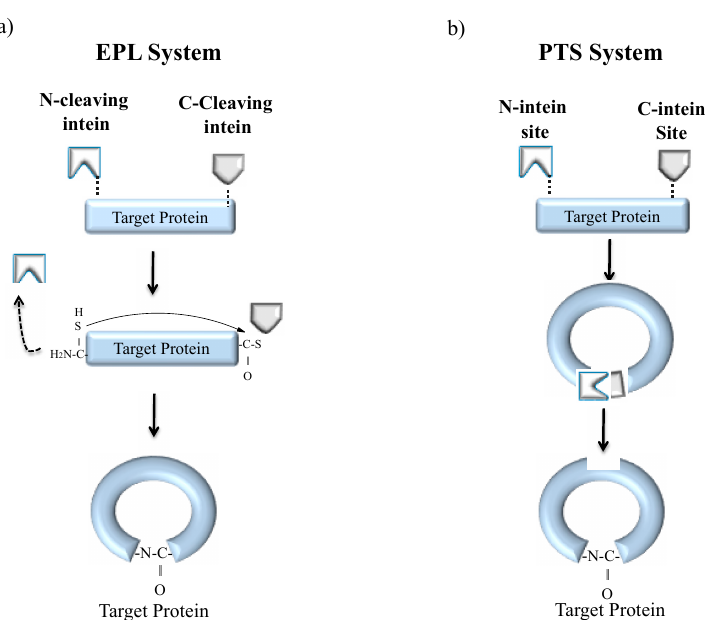
Figure 8. Schematic representation of intein-mediated post-translational modification of a target protein. ( a ) Expressed protein ligation (EPL) systems involve a nucleophilic attack by an N-terminal Cys residue on a thioester formed by a downstream intein. The N-terminal Cys can be generated by a second, upstream intein or by conventional proteolytic cleavage. ( b ) Protein trans -splicing (PTS) methods involves cyclization of a target protein tagged with N- and C-intein, which leads to assembly and splicing of an inverted split intein, resulting in generation of a functional target protein.